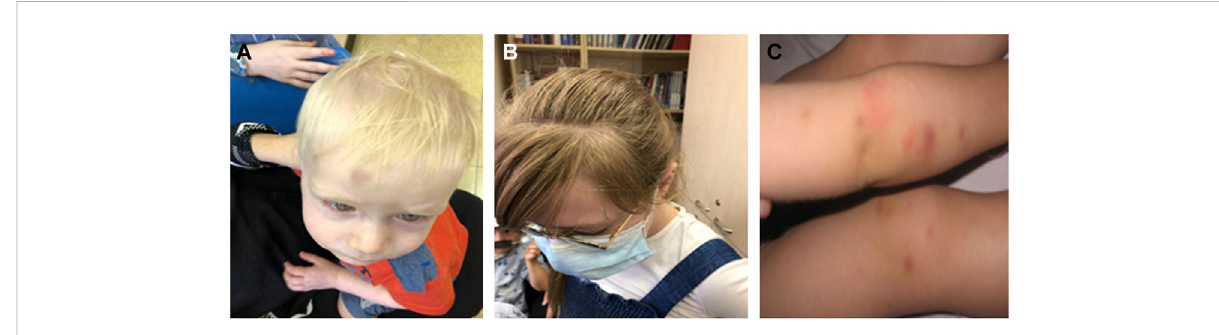
FIGURE 1 Clinical manifestations of Hermansky – Pudlak syndrome (HPS)-3 patients. HPS-3 patients have variable hypopigmentation of skin and hair, as shown in probands 4 and 5 (B-II:8 and B-II:9, respectively) (A – B) , and some show multiple ecchymoses due to a bleeding diathesis in HPS patients (proband 5) (C)